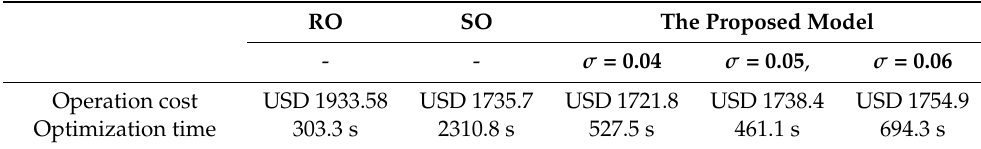
Table 6. Optimization results under different